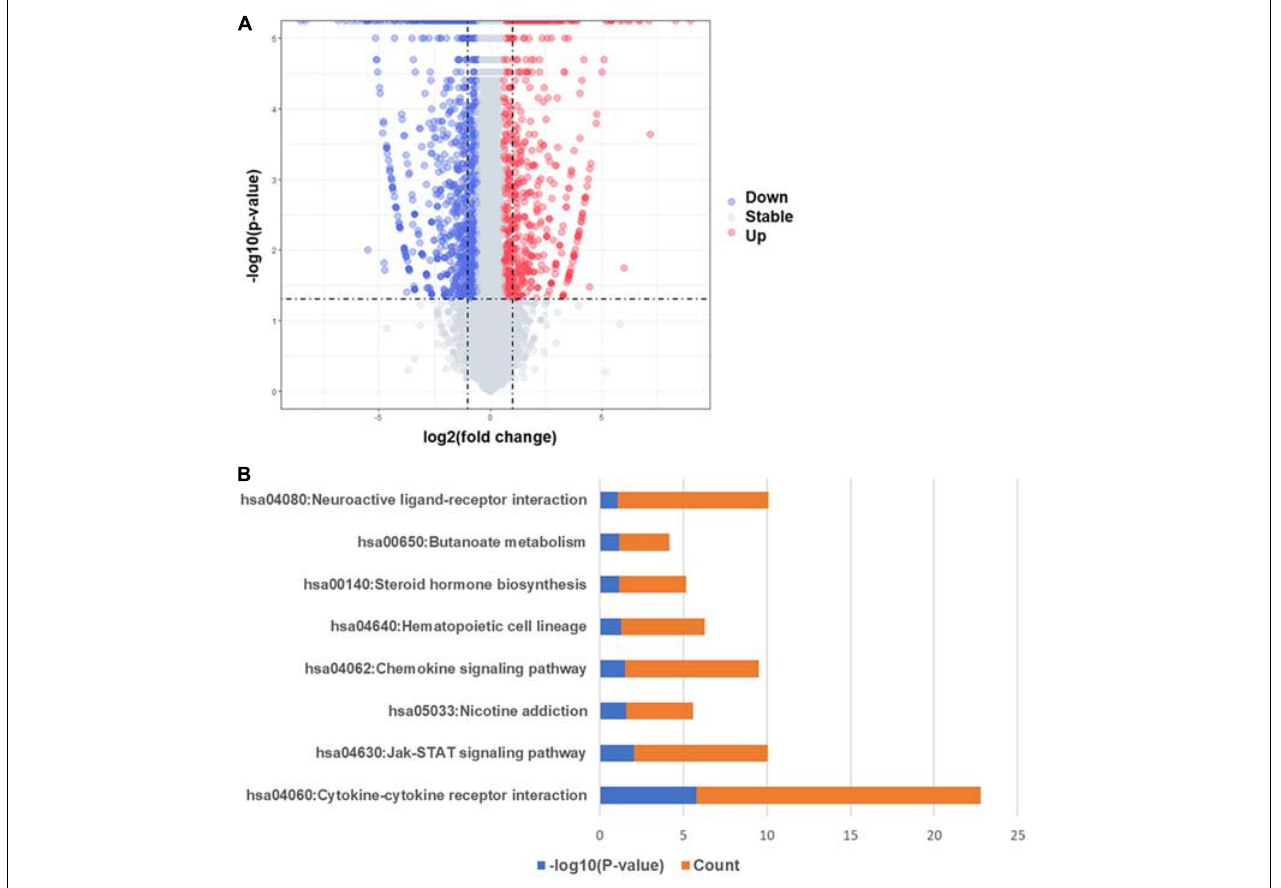
FIGURE 2 | Differentially expressed genes and KEGG pathway enrichment analysis. (A) Volcano map of differentially expressed genes, red spots represent up-regulated genes and blue spots represent down-regulated genes. (B) KEGG pathways significantly associated with the upregulated